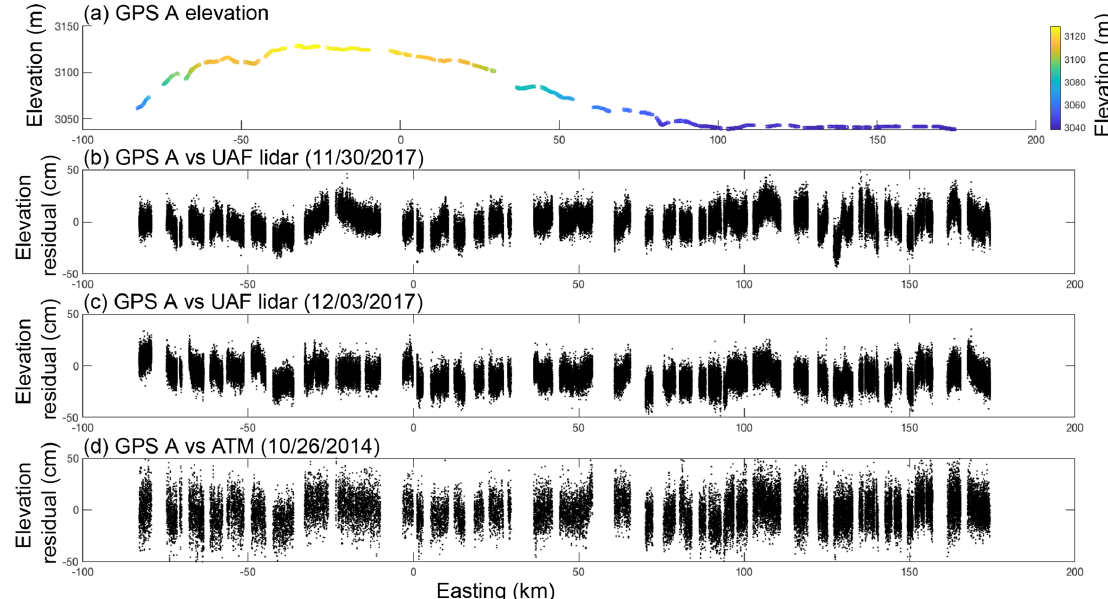
Figure 4. Along-track elevation and elevation differences associated with GPS A. (a) Along-track elevation of GPS A, in meters. (b) Elevation difference between GPS A and the UAF lidar (30 November 2017), minus the mean difference. (c) Elevation difference between GPS A and the UAF lidar (3 December 2017), minus the mean difference. (d) Elevation difference between GPS A and ATM (26 October 2014), minus the mean